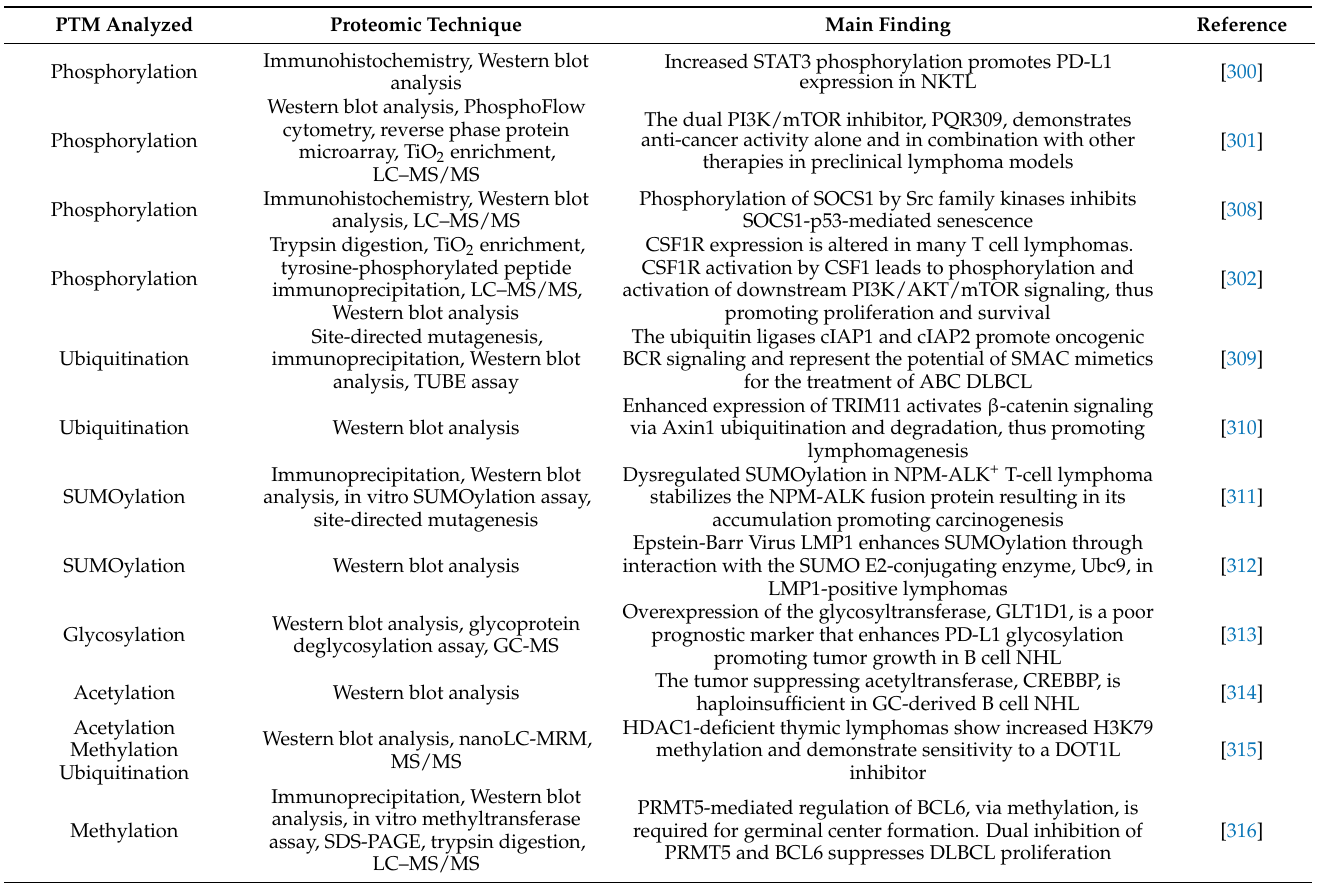
Table 5. Recent studies utilizing proteomic techniques to analyze PTMs in